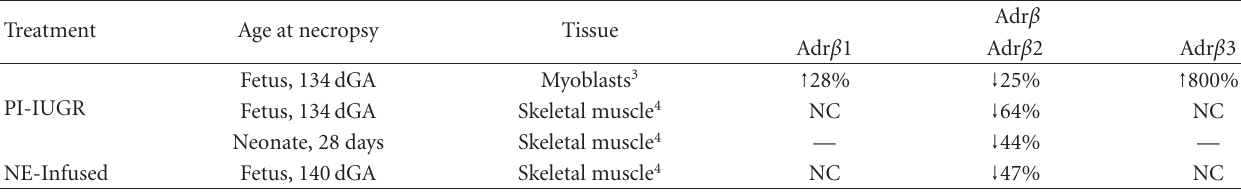
Table 1: Adrenergic receptor β (Adr β ) mRNA expression determined by quantitative PCR in placental insu ffi ciency-induced IUGR 1 and norepinephrine-infused 2 sheep fetuses relative to control